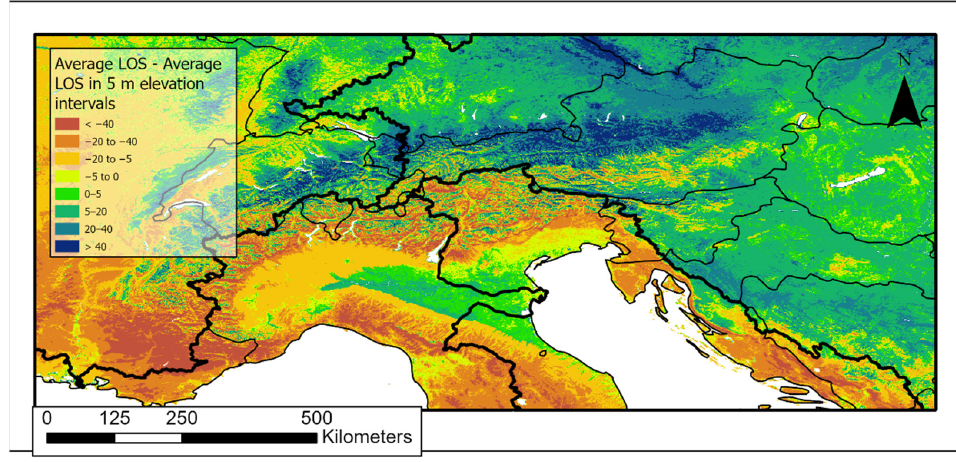
Figure 4. Differences between the LOS grid point values and the medians of the distributions of the GAR LOS values falling in the corresponding 5-m elevation intervals.